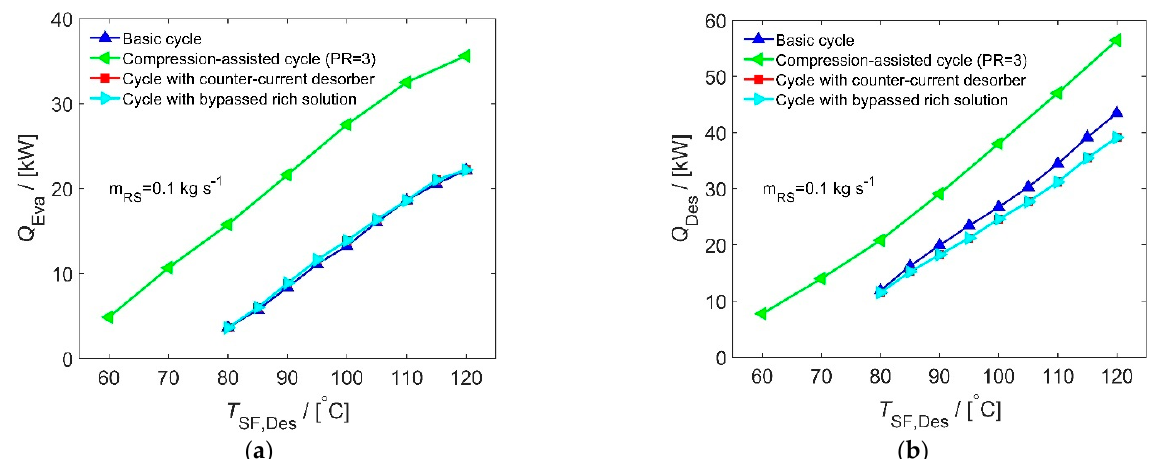
Figure 15. Performance comparison of different cycles. ( a ) Cooling capacity, ( b ) Heating capacity.